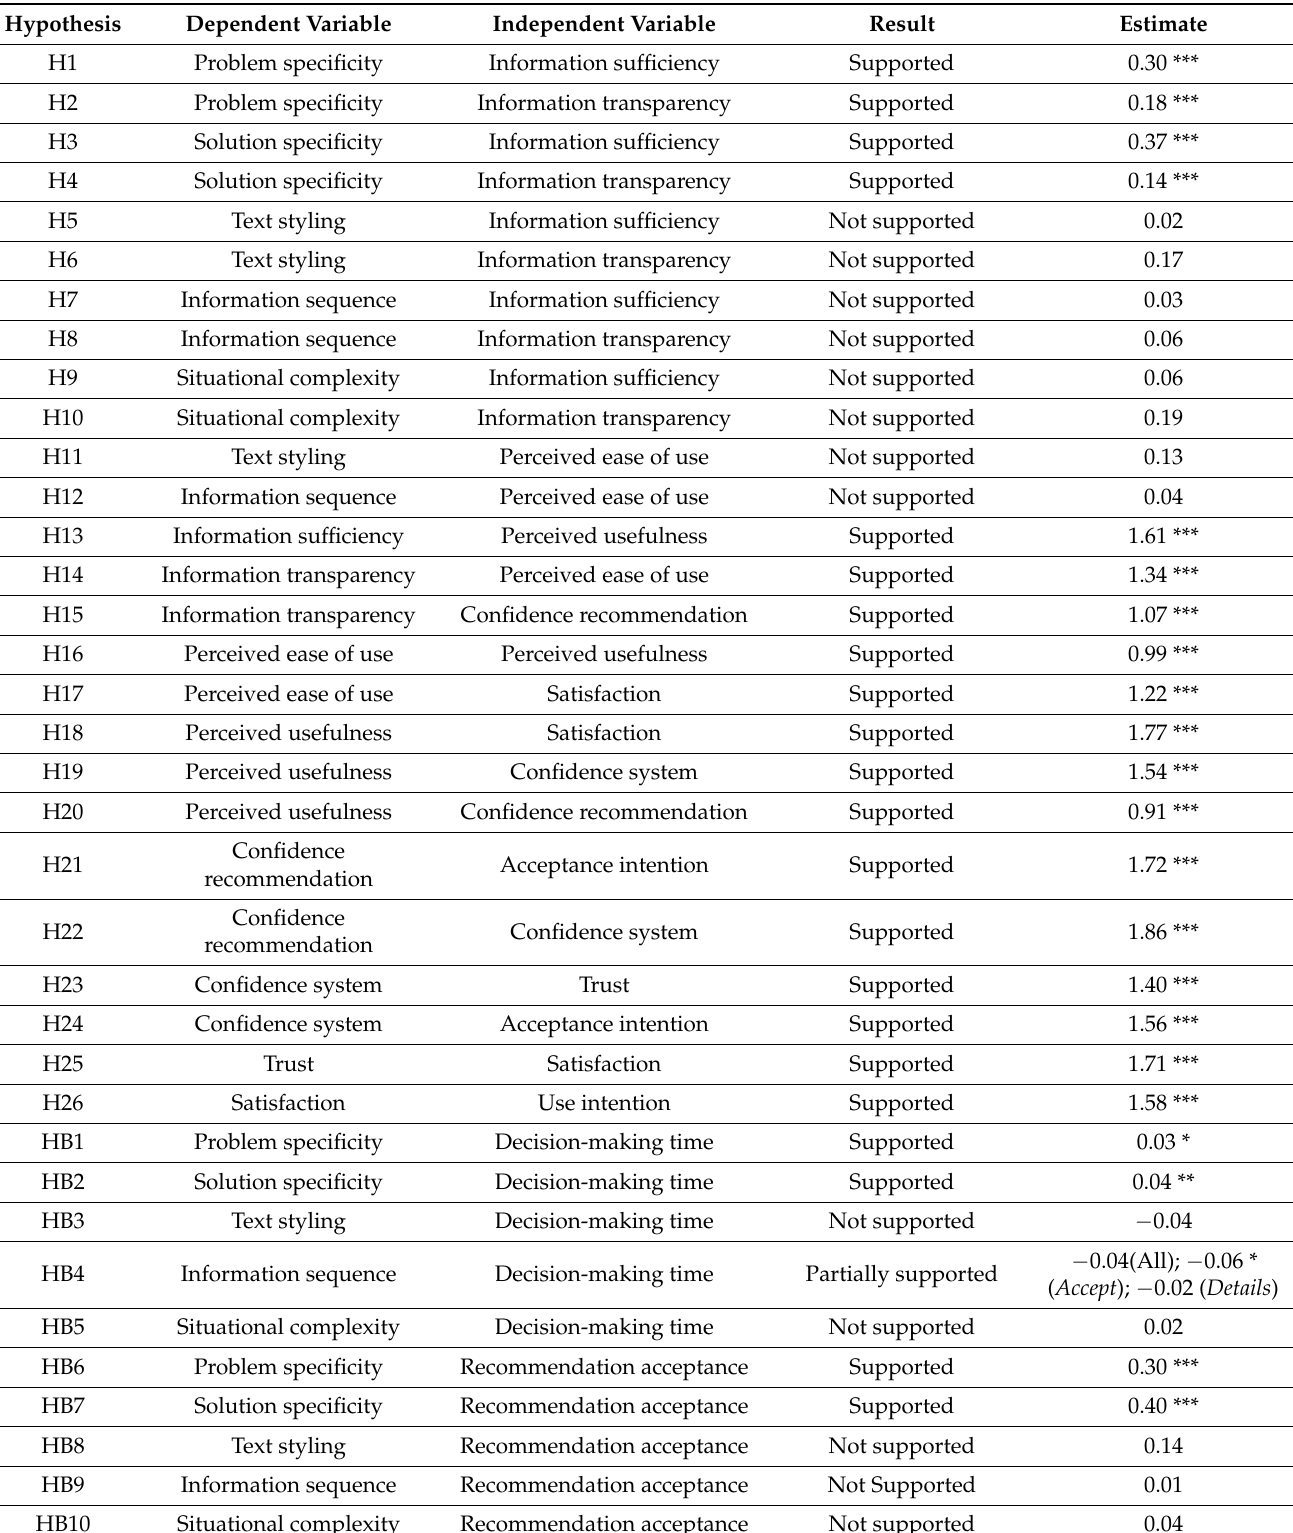
Table 3. Summary table of all the hypotheses and their